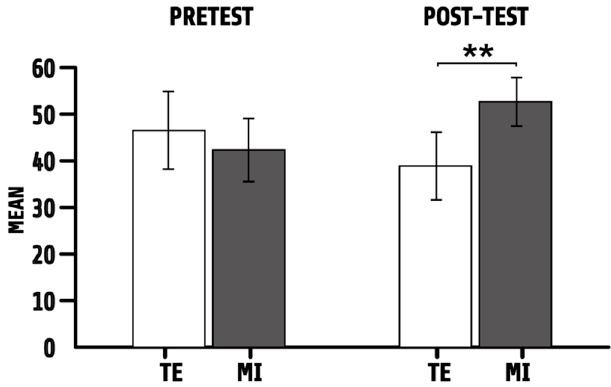
Figure 2. Graphical representation of the mean scores value (error bars: 95% confidence interval) obtained by the control and experimental groups clustered by pretest and post-test. The students involved in multisensory instruction (MI) during the reinforcement lesson obtained a significantly higher mean value for scores on the post-test compared to students asked to solve textbook exercises as reinforcement lesson (TE) (** p -value = 0.010, α ≤ 0.05).